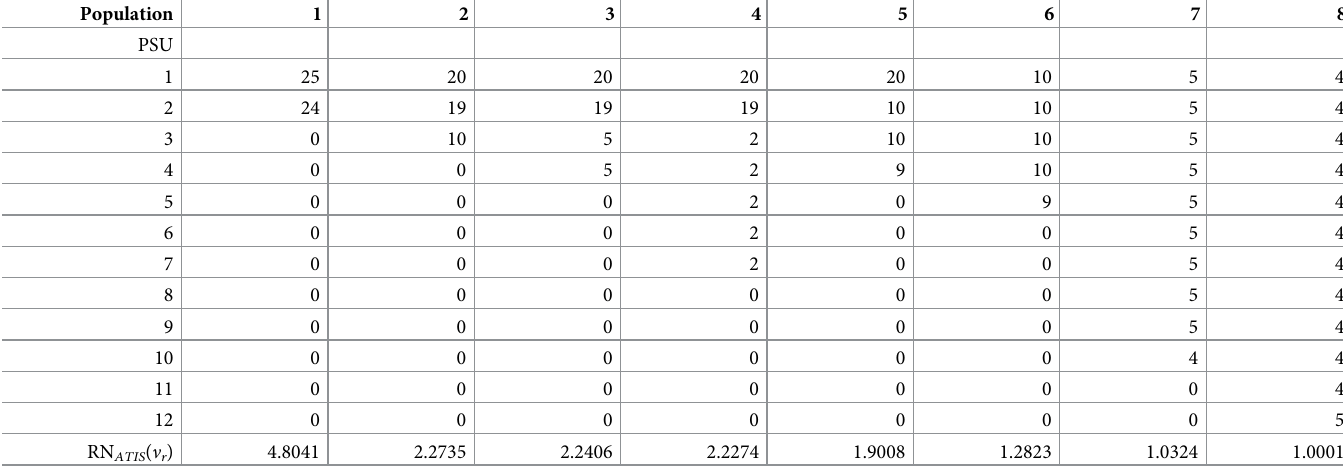
Table 1. Eight imaginary populations are considered. Each population consists of 49 rare units. Those rare units are distributed among 12 PSUs which are resembling the buttercup population with different distribution of rare units. The numbers inside the table are the number of rare units in each PSU. The relative expected number of observed rare units, RN ( ν ) are computed for each population. ATIS r